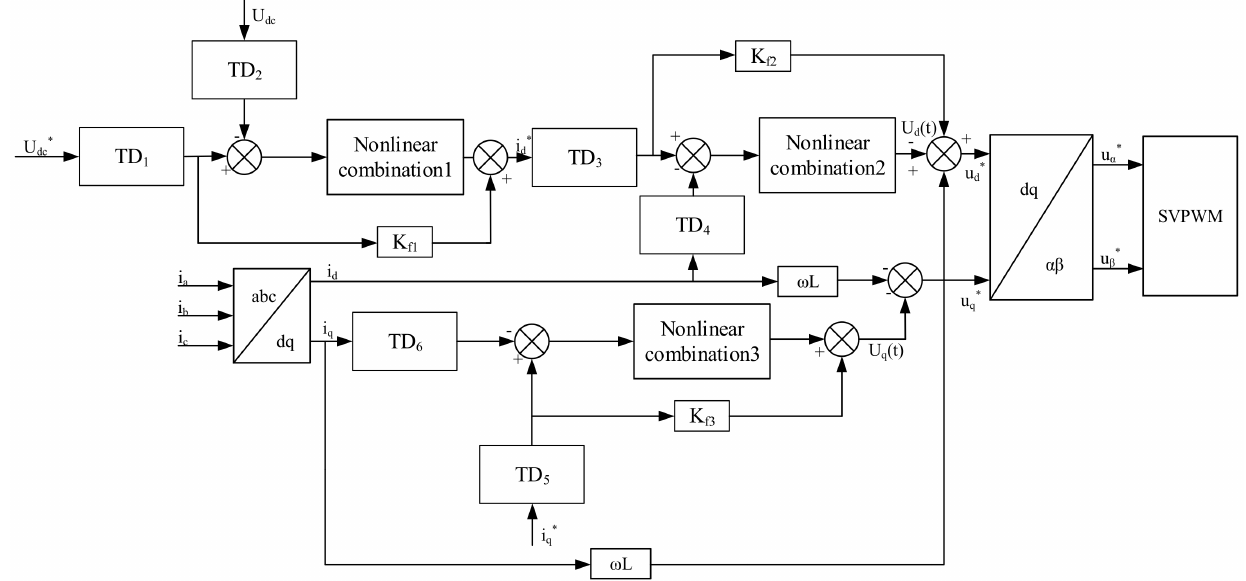
Figure 4. System diagram of the double closed-loop